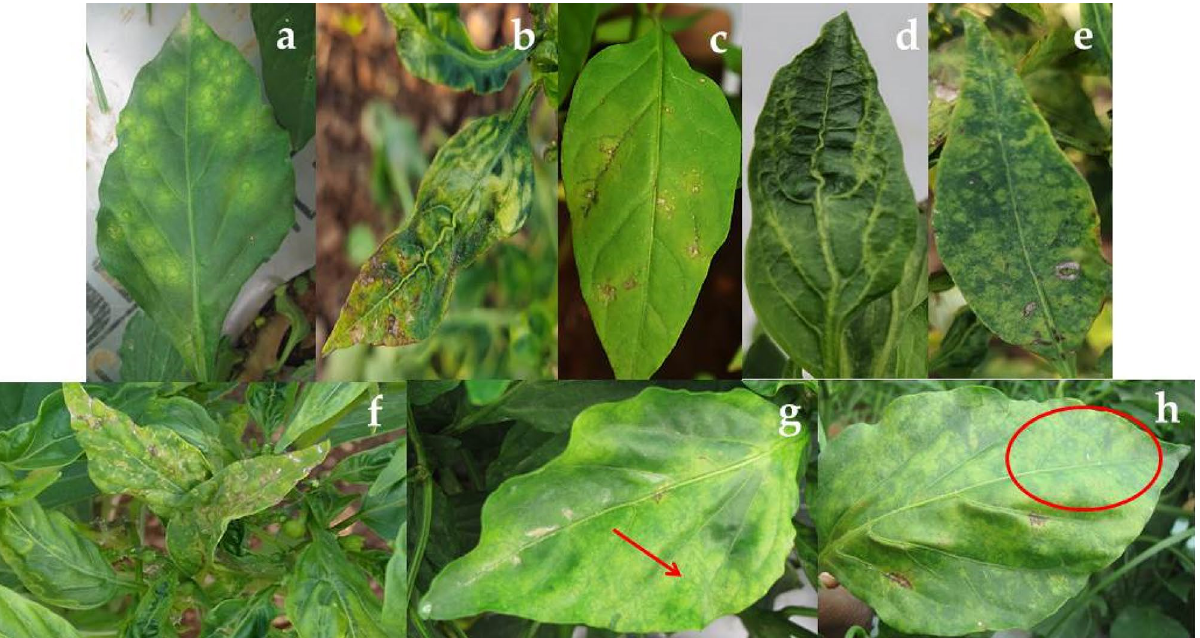
Figure 1. Symptoms observed on infected chilli plants: ( a ) cocncentric chlorotic ring spots; ( b ) necrotic lesions; ( c ) veinal necrosis; ( d ) leaf malformation; ( e , f ) necrosis along with mosaic (recorded mixed infection of CMV and GBNV); ( g , h ) mosaic with chlorotic ring spots; mark indicates concentric chlorotic rings (recorded mixed infection of CMV and